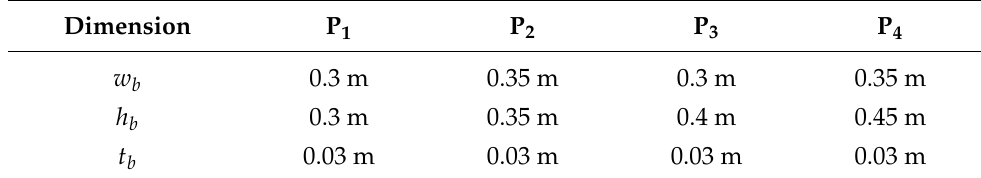
Table 3. Dimensions of the cross sections used for the beams and